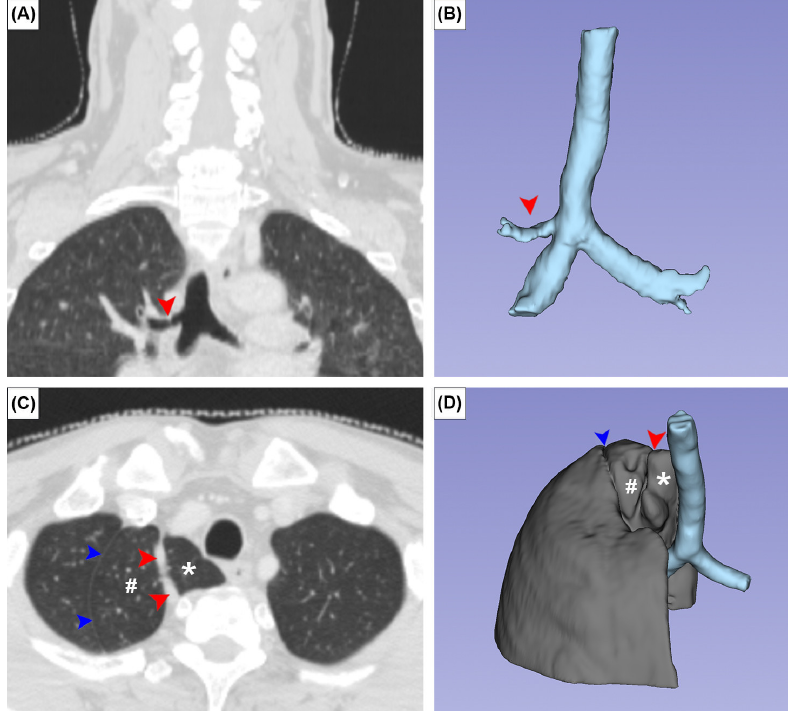
Figure 4. Coronal ( A , C ) CT images and three-dimensional images of the tracheal bronchus ( A , B ) and azygos lobe ( C , D ). Red arrowheads and asterisks indicate the azygos fissure and azygos vein, respectively. Blue arrowheads and # indicate a variant placement of the oblique fissure and unusually small superior lobe of the right lung.